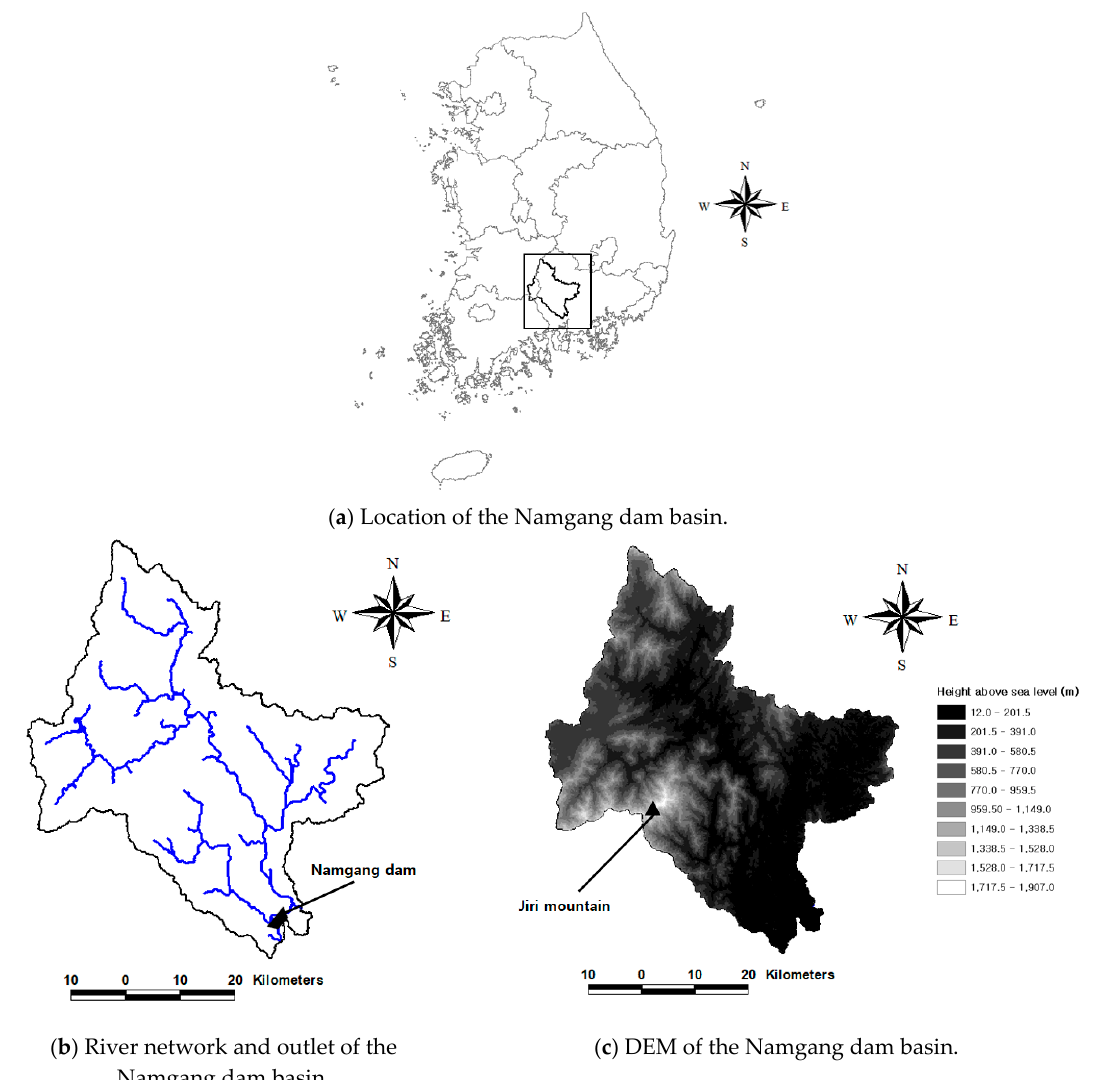
Figure 2. Location of the Namgang dam basin and its characteristics.